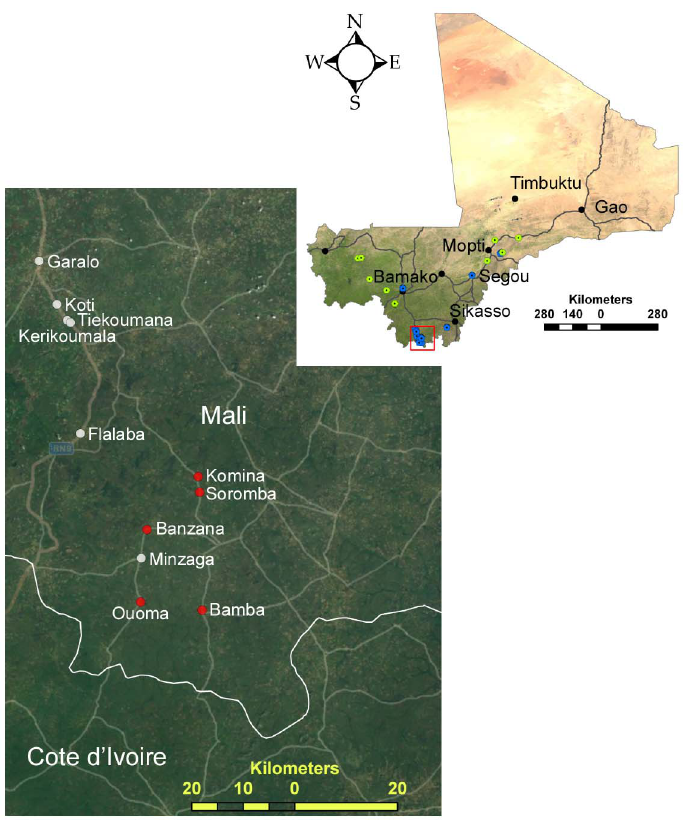
Figure 1. Map of Mali depicting the various locations where small mammals were trapped. Sera and tissue samples were collected at some locations (blue dots) whereas at other locations only sera were collected (green dots). The major cities of Mali are represented by black markers. Inset is an expanded view of southern Mali where the occurrence of Lassa virus infected rodents was documented. The sampled villages are named, and red markers indicate villages where Lassa virus infected rodents were documented. The maps were generated using ESRI ArcMap 10.1; the map of Mali utilizes an ESRI satellite imagery basemap and the inset utilizes an ESRI basemap with the imagery and transportation layers activated, both supplied with the GIS software.